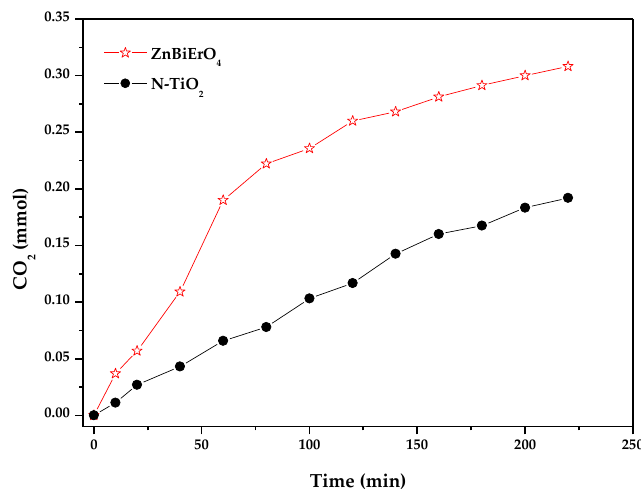
Figure 15. Production of CO 2 during the photocatalytic degradation of methyl blue with ZnBiErO 4 or N-TiO 2 as catalyst under visible light irradiation.